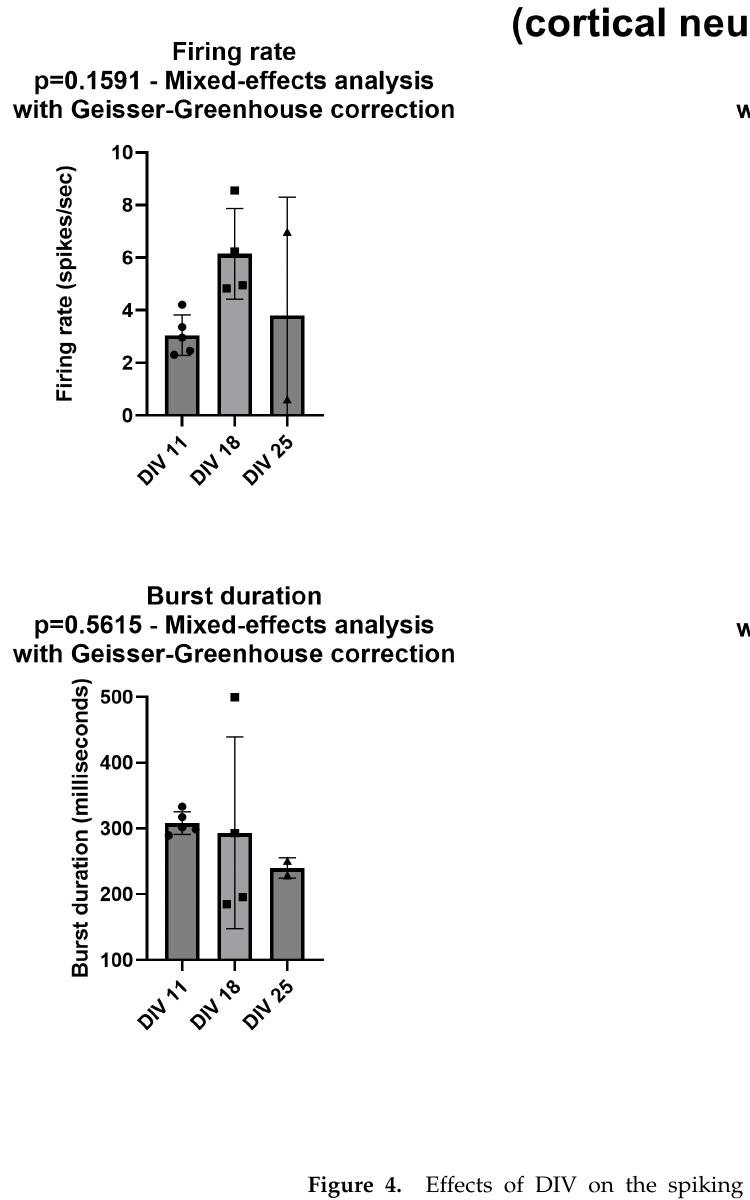
Figure 4. Effects of DIV on the spiking and bursting parameters. All parameters refer to spontaneous—not stimulus-evoked—activity. Bars and lines represent mean and standard deviation. Filled circles represent individual data. Asterisks mark statistically significant differences from DIV 11 (number of asterisks represent number of decimal zeroes before non-zero number, e.g., ** = p < 0.005). ns—not significant. See text for additional explanations.